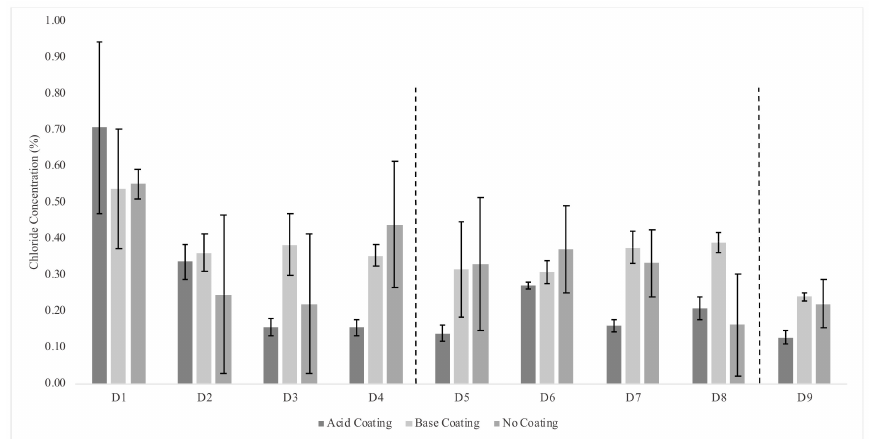
Figure 5. Cl − aerosol concentration on the denuder walls for the 9-ADS set-up. The vertical dashed lines represent the location of U-Bends in the system. The values are given as the average percentage of the three trials conducted per coating type (acid, base, or no coating) for a total of nine